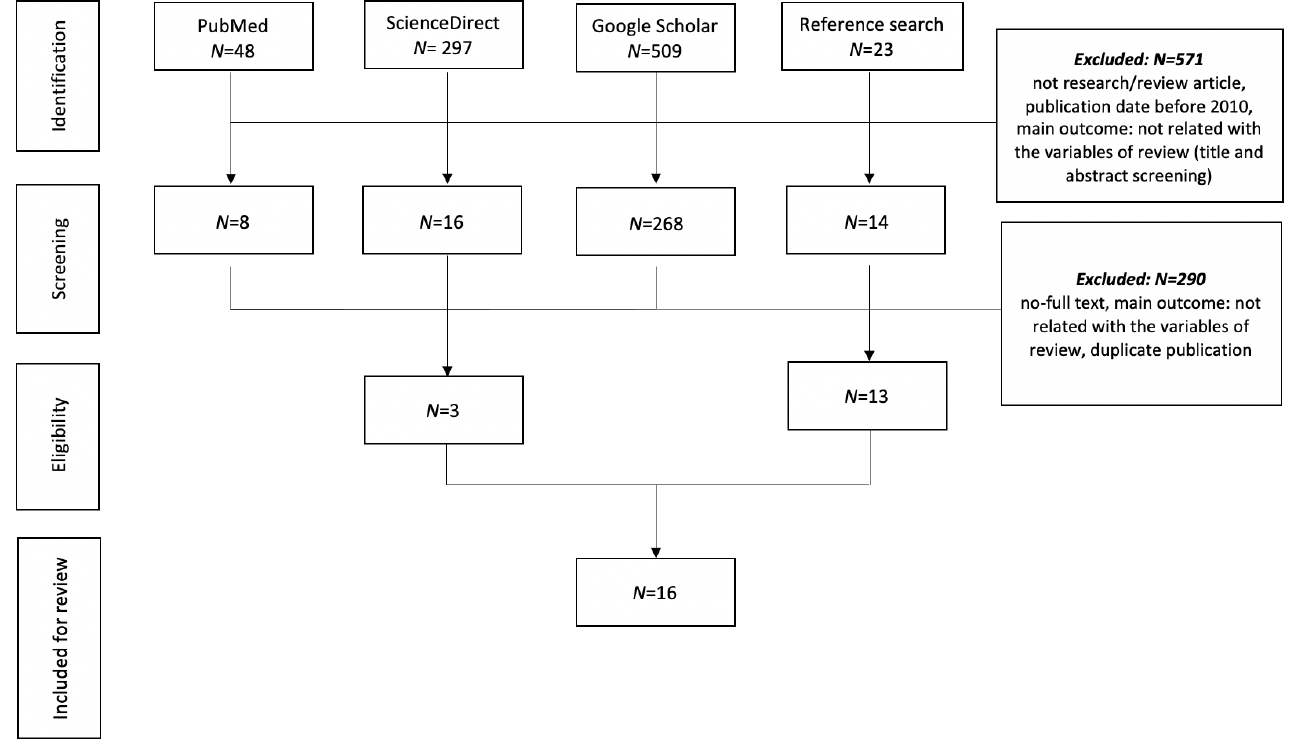
Figure 1. The literature search process .